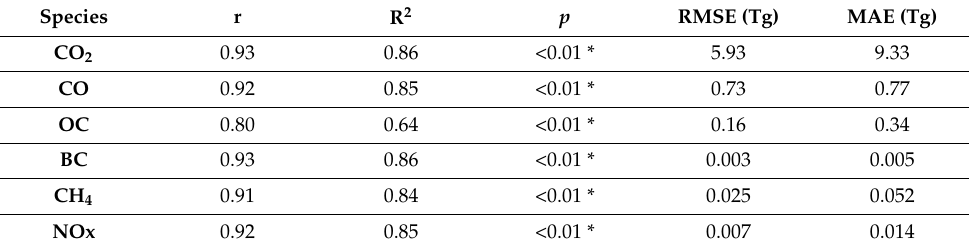
Table 5. The statistical association between the estimated emissions from forest fire and the GFED4.1s- derived emissions (in